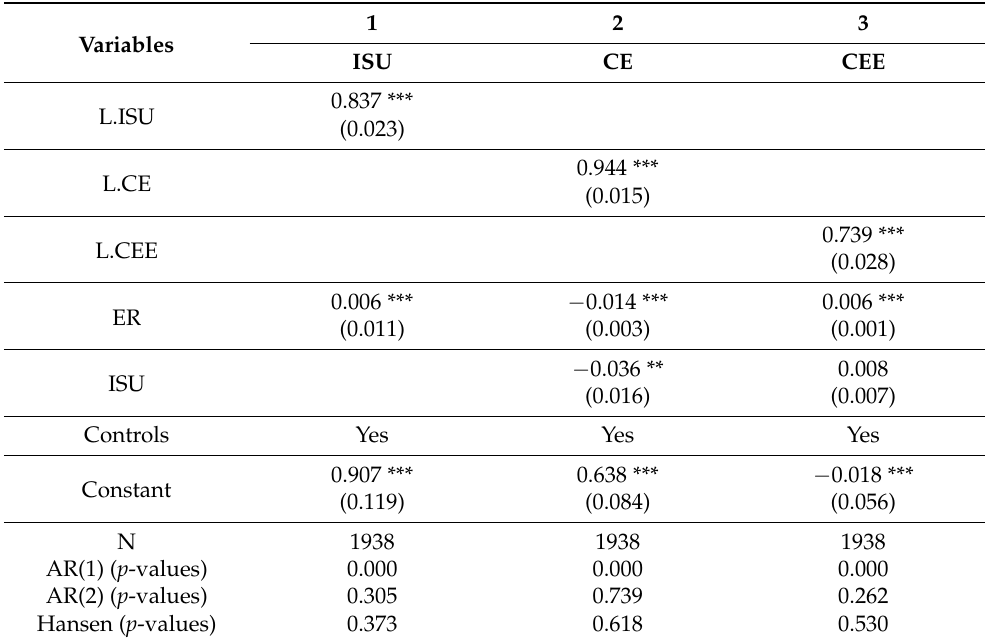
Table 7. Regression results of mechanism analysis for industrial structure